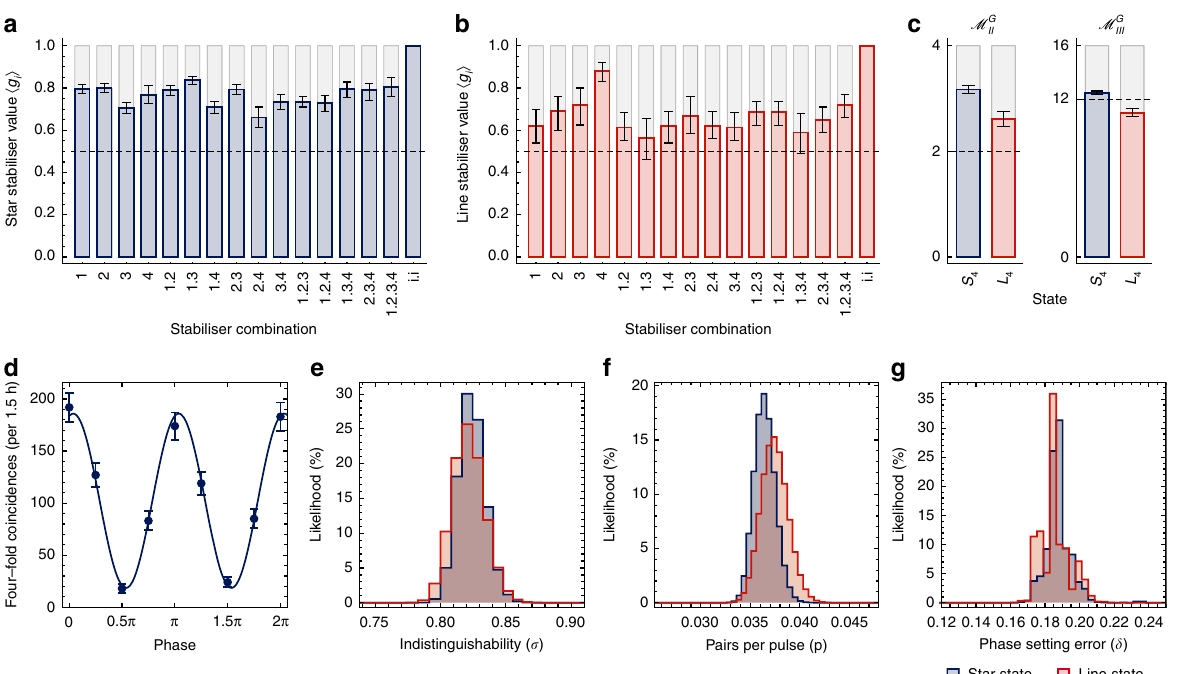
Fig. 2 Summary of experimental data. a , b Stabiliser observables of the star and line graph states, 〈 S 4 | g i | S 4 〉 and 〈 L 4 | g i | L 4 〉 , used to estimate state fi delity. Dashed lines indicate the F > 1/2 threshold to witness genuine multipartite entanglement, where F = mean{ 〈 g i 〉 }. The fi nal bar of each plot, g i g i , is the identity for any i ∈ {1, 2, 3, 4}. c Mermin parameters M G and M G for the | S 4 〉 and | L 4 〉 states, estimated from stabilisers measurements. Local hidden II III variable bounds are indicated with a dashed line. Values are reported in Table 1. d On-chip Hong-Ou-Mandel interference, with HOM fringe visibility of V = 0.82 ± 0.02. Probability distributions for the e indistinguishability, f source brightness, and g phase error, derived via a Bayesian parameter estimation method. All error bars represent the standard error of the mean, obtained from Monte Carlo simulations assuming a Poissonian distribution of the measured counts